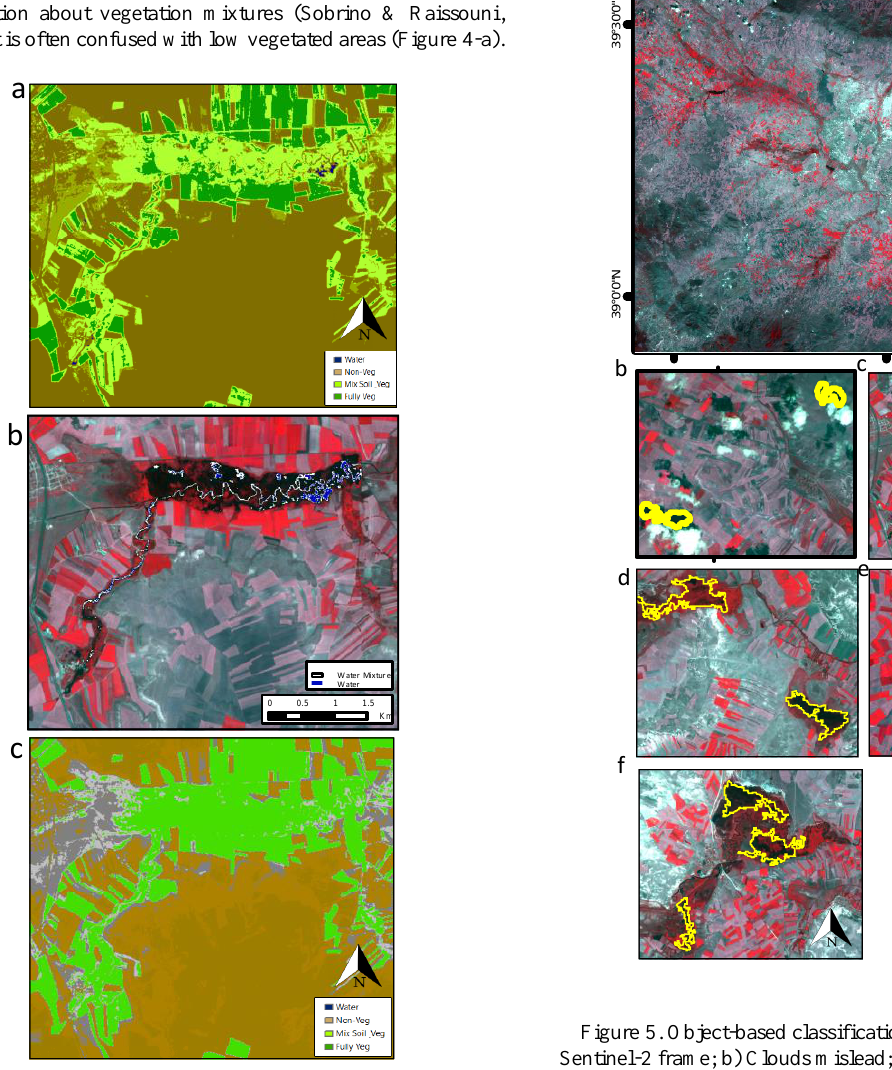
Figure 4. Index based classification; A) NDVI results; B) NDWI results; C) MSAVI2 results.